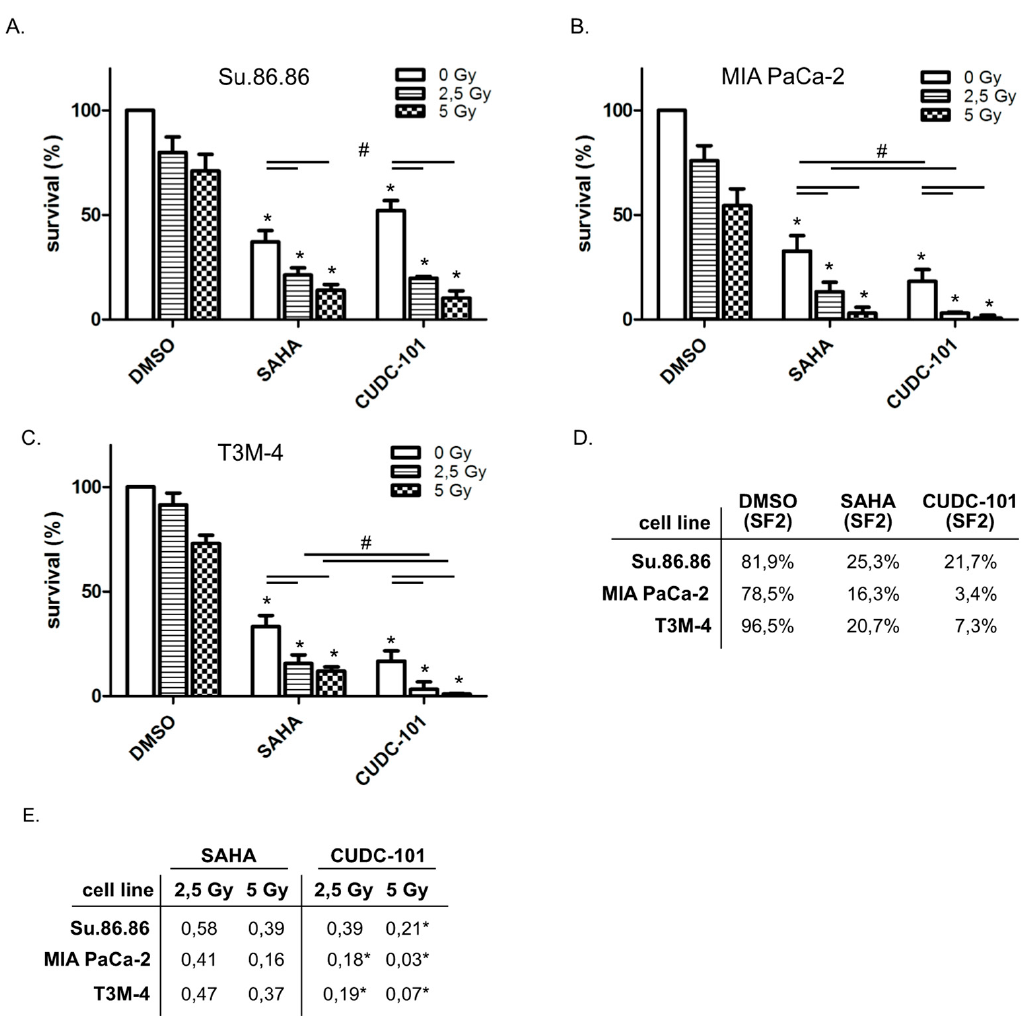
Figure 2. Clonogenic survival decreased more efficiently by combined CUDC-101 and radiation than by SAHA and radiation. Su.86.86 ( A ), MIA PaCa-2 ( B ) and T3M-4 cells ( C ) were treated with SAHA (1.5 µM) or CUDC-101 (0.5 µM) for 24 h, then cells were irradiated with 0, 2.5 or 5 Gy. After 10 days colonies bigger than 50 cells were counted. The mean of three independent experiments ± SD is shown. For statistical analysis, ANOVA was performed with post hoc Bonferroni multiple comparisons. * Indicates comparison with DMSO control, p < 0.05; # indicates comparison between SAHA and CUDC-101, p < 0.05. ( D ) Survival fractions after irradiation with 2 Gy. ( E ) Mean n -fold changes between inhibitor treatment compared to combined inhibitor/radiation treatment, * indicates comparison between SAHA and CUDC-101 treatment at the indicated dose, p < 0.05).